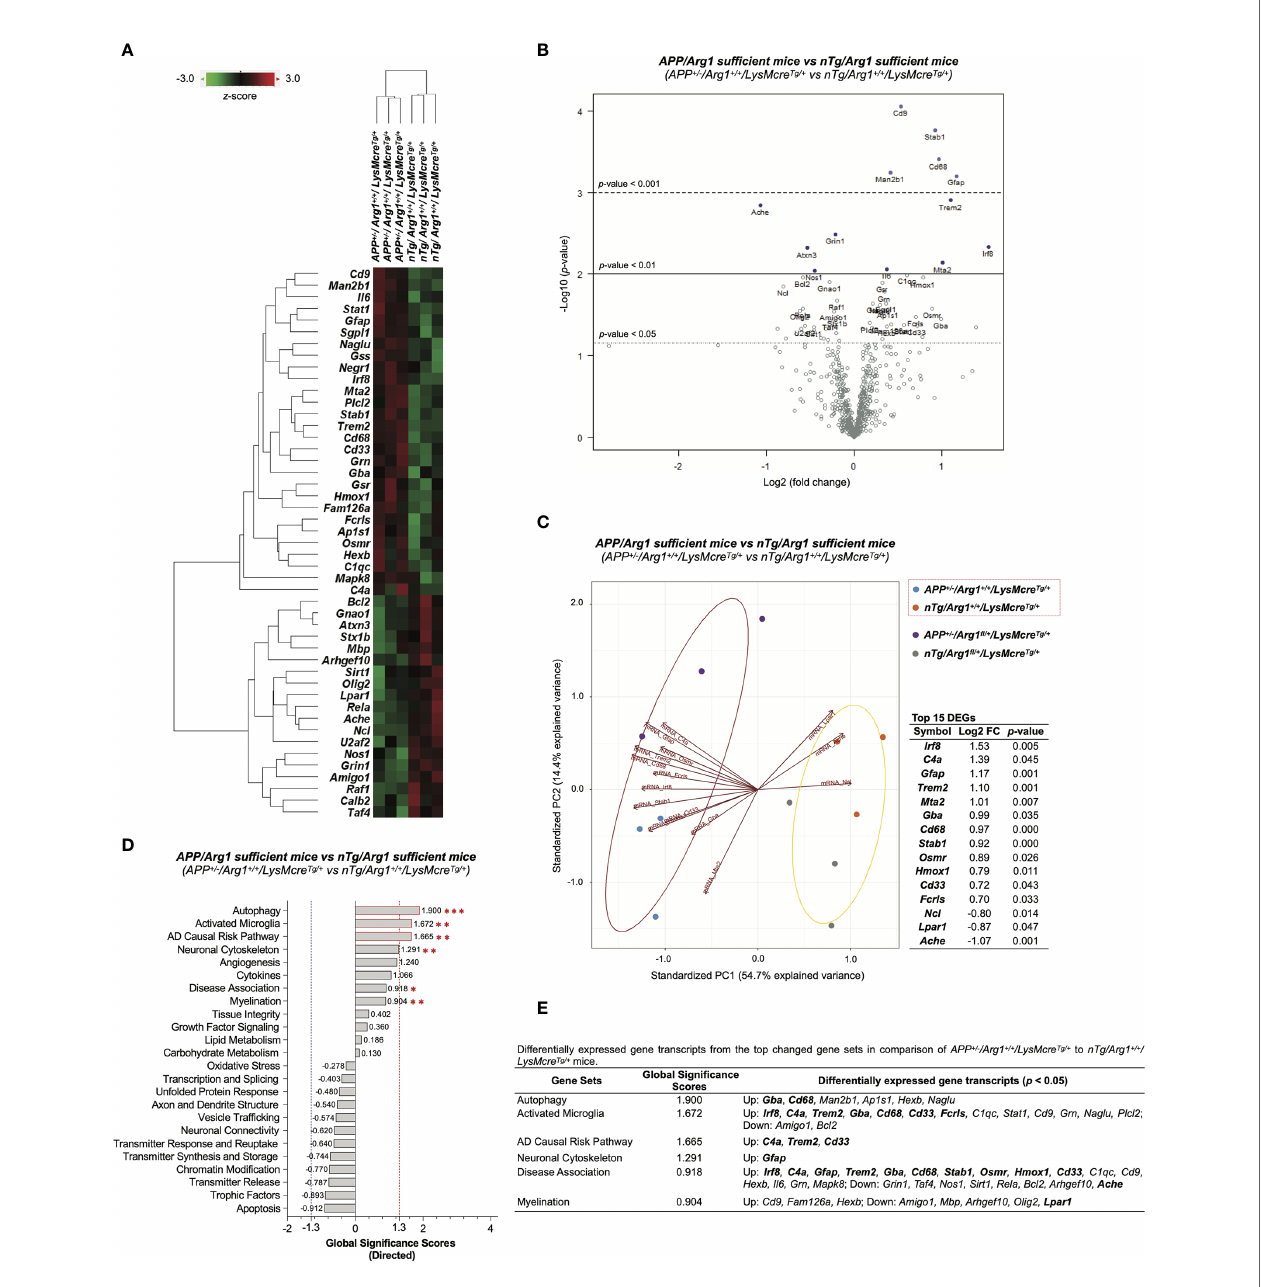
FIGURE 6 | Differential gene expression analysis of overexpressing human APP KM670/671NL Swedish mutation in mouse brain. (A) A heat map with dendrogram trees represents clustering of samples and differentially expressed gene transcripts (DEGs, p < 0.05) by comparing APP +/- /Arg1 +/+ /LysMcre Tg/+ to nTg/ Arg1 +/+ /LysMcre Tg/+ mice. The heat map uses the average Euclidean distance for the linkage and is centered and scaled by the z -score transformation. Red and green colors denote up and down expressed gene transcript, respectively. (B) A volcano plot displays all expressed genes above the background. Gene transcripts with high statistical signi fi cance stay on the top and high fold-change stay on either side. The left and right side of the volcano plot displays the down and up expressed genes, respectively. Horizontal lines indicate different thresholds of the p -values. The top 40 DEGs (based on p -values) are labeled. (C) A biplot of principal component analysis and a table are created by the top 15 DEGs with the highest fold-change variance. (D) A bar graph of gene set analysis ranks all signature pathways with directed global signi fi cance scores (GSS). The up or down regulated pathway is indicated by positive or negative GSS values. The red or blue dashed line highlights the top changed pathways based on the cut-off criterion (absolute GSS value at 1.3). The statistically changed pathways from pair-wise comparison in pathway scoring analysis are annotated with red asterisk sign (*) for up-regulation. (E) A table lists DEGs of the top changed pathways from both gene set analysis and pathway scoring analysis. The top 15 DEGs are bolded. Up/Down denotes up/down-regulation. n=3 samples per group representing 6 mice. The asterisk sign (*) indicates the focused pair-wise comparison of APP transgene genotype. * p < 0.05, ** p < 0.01; *** p < 0.001. Two-way ANOVA of 2x2 factorial analysis followed by pairwise comparisons using Fisher ’ s PLSD. See also Table S1